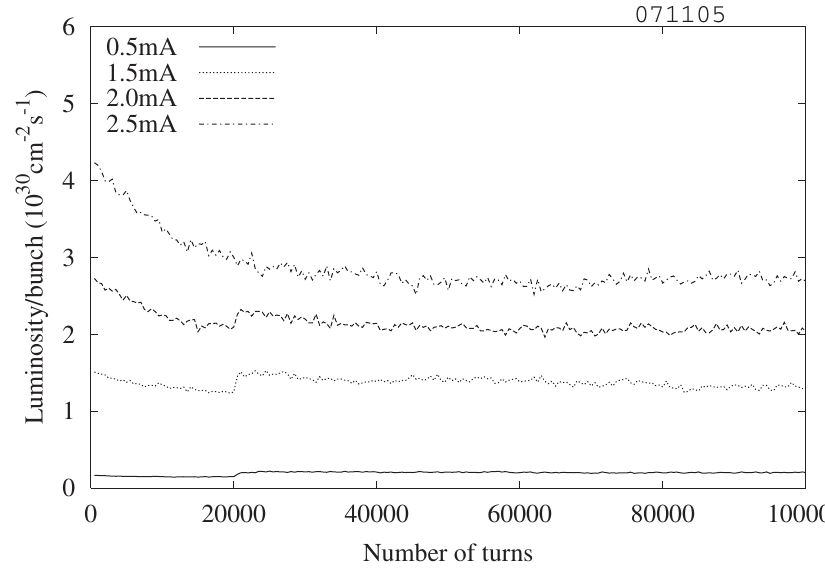
FIG. 4. Luminosity computed every 500 turns versus turn number for various bunch currents.